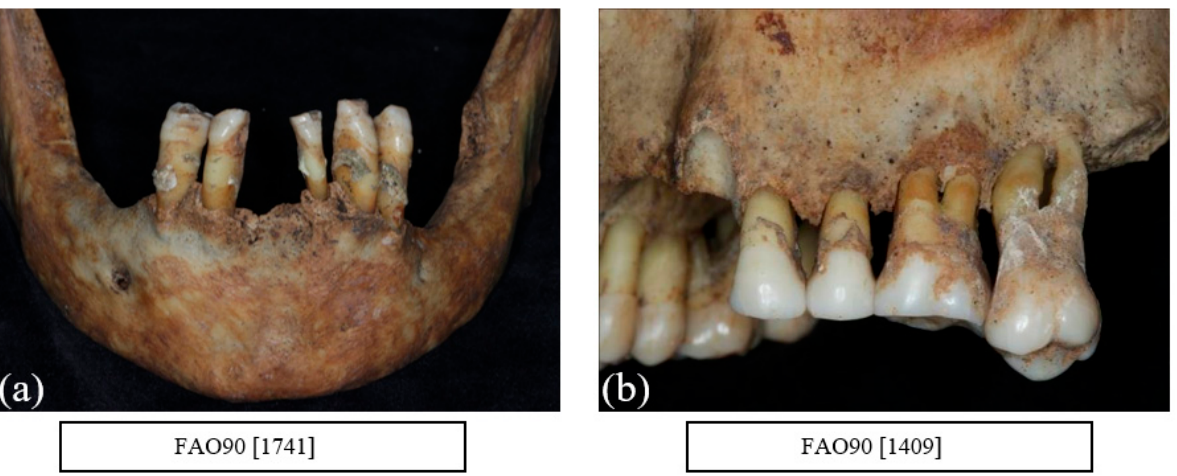
Figure 3. Illustration of generalised moderate to severe horizontal bone loss affecting both the anterior teeth in the mandible (lower jaw) (( a ) FAO90[1741]) and the posterior teeth in the maxilla (upper jaw) (( b ) FAO90[1409]) (courtesy of the Museum of London). According to Case definition I, 21% of adults were affected with moderate to severe periodontitis ( n = 22). Older adults showed a higher prevalence compared to the rest of the age groups ( p < 0.001). No differences were observed between males and females (22.7%, 17.9%) ( p = 0.899) (Table 6). Table 6. Cases with moderate to severe periodontitis (age and sex) based on case definition I and